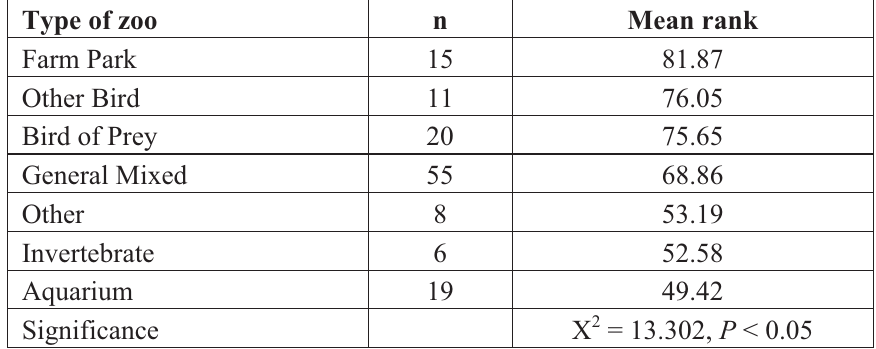
Table 4. Effect of type of zoo on total number of criteria continuing to be substandard between first and second inspections. The type of zoo is based on [5]; higher mean ranks indicate that more criteria were assessed as being substandard at both the first and second inspection. Since there was only one “Big Cat” zoo and one “Reptile Amphibian” zoo in the sample, they were excluded from the analyses. Assessments of different types of zoo were compared with Kruskal-Wallis tests: n = 134 zoos. Type of zoo